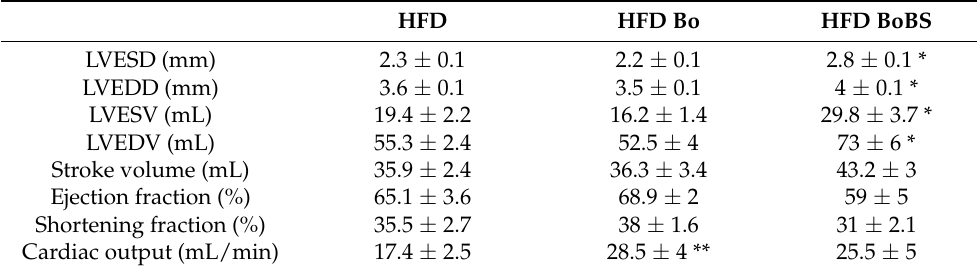
Table 3. Heart function throughout the